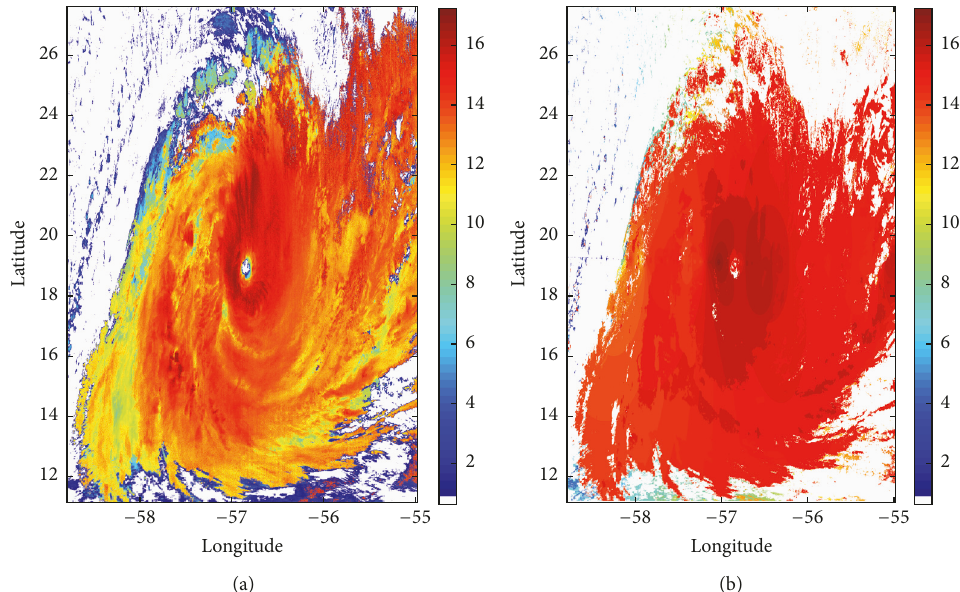
Figure 15: Comparison of MODIS CTH product (a) and retrieved CTH results (b) using the